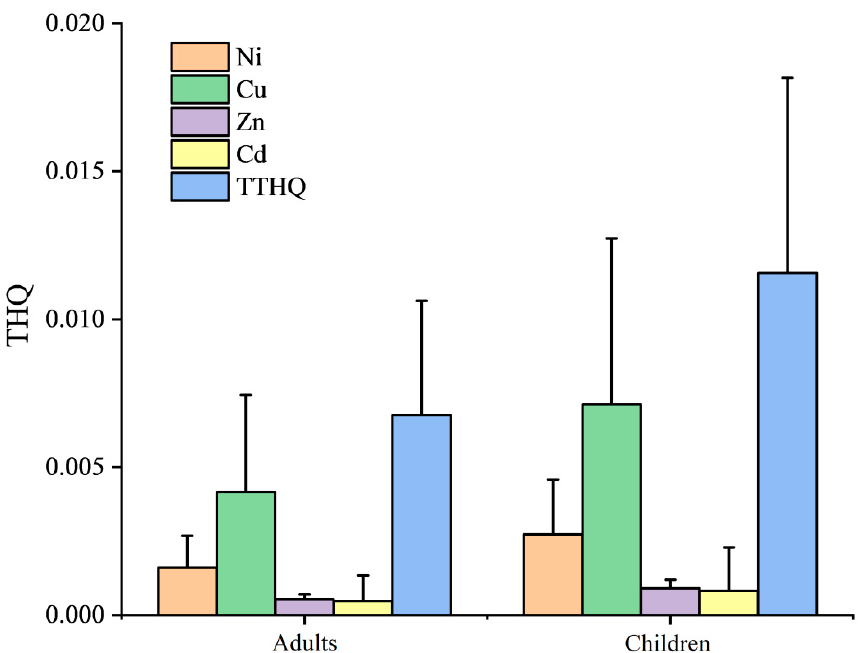
Figure 5. THQ of heavy metals for consuming winter jujube fruits.